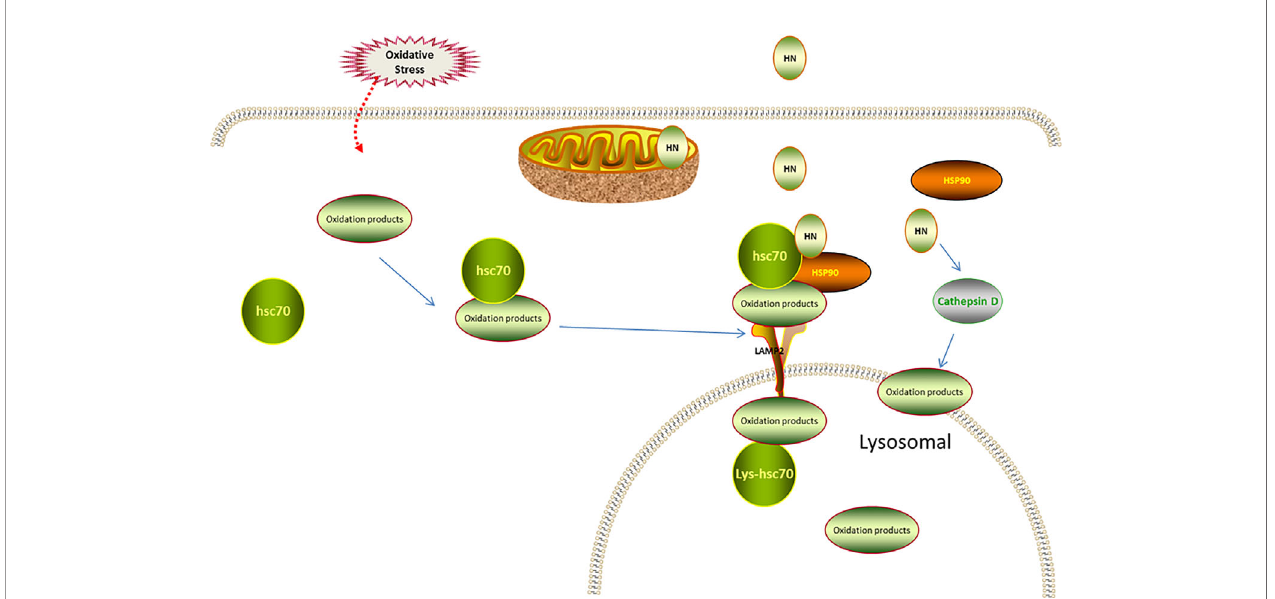
FIGURE 3 | Regulation of HN on CMA under oxidative stress. Under oxidative stress, Hsc70 recognizes the oxidized protein (substrate), transports it to lysosomal membrane, and binds to LAMP-2 receptor on lysosomal membrane. The endogenous HN located in lysosomal membrane cytoplasmic assay stabilizes the binding of substrate and lysosome through Hsp90, and transports the substrate to lysosomal body with the assistance of Lys-Hsc70 to remove oxidized protein. Exogenous supplement of HNG enhances the binding of substrate and lysosome mediated by Hsp90, up-regulates CMA and further reduces oxidative stress damage. HN restores the activity of cathepsin D through FPRL1, promotes autophagy and reduces the production of ROS.